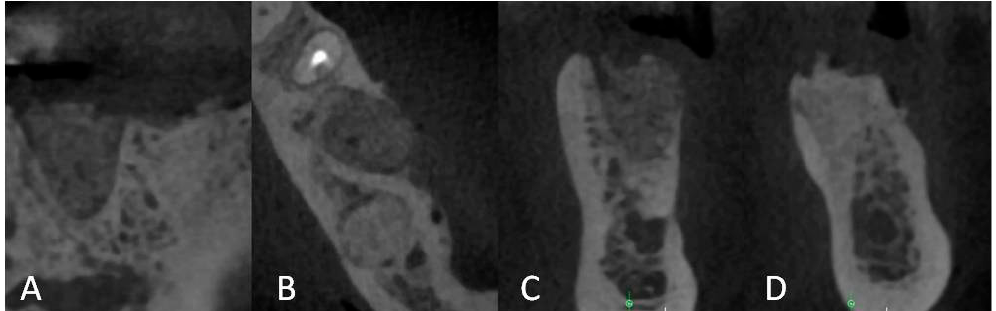
Figure 3. Postoperative 3D radiographic analysis (Acteon X-Mind Trium) in ( A ) sagittal and ( B ) axial projection, and cross-sections of Regions ( C ) 35 and ( D ) 36.